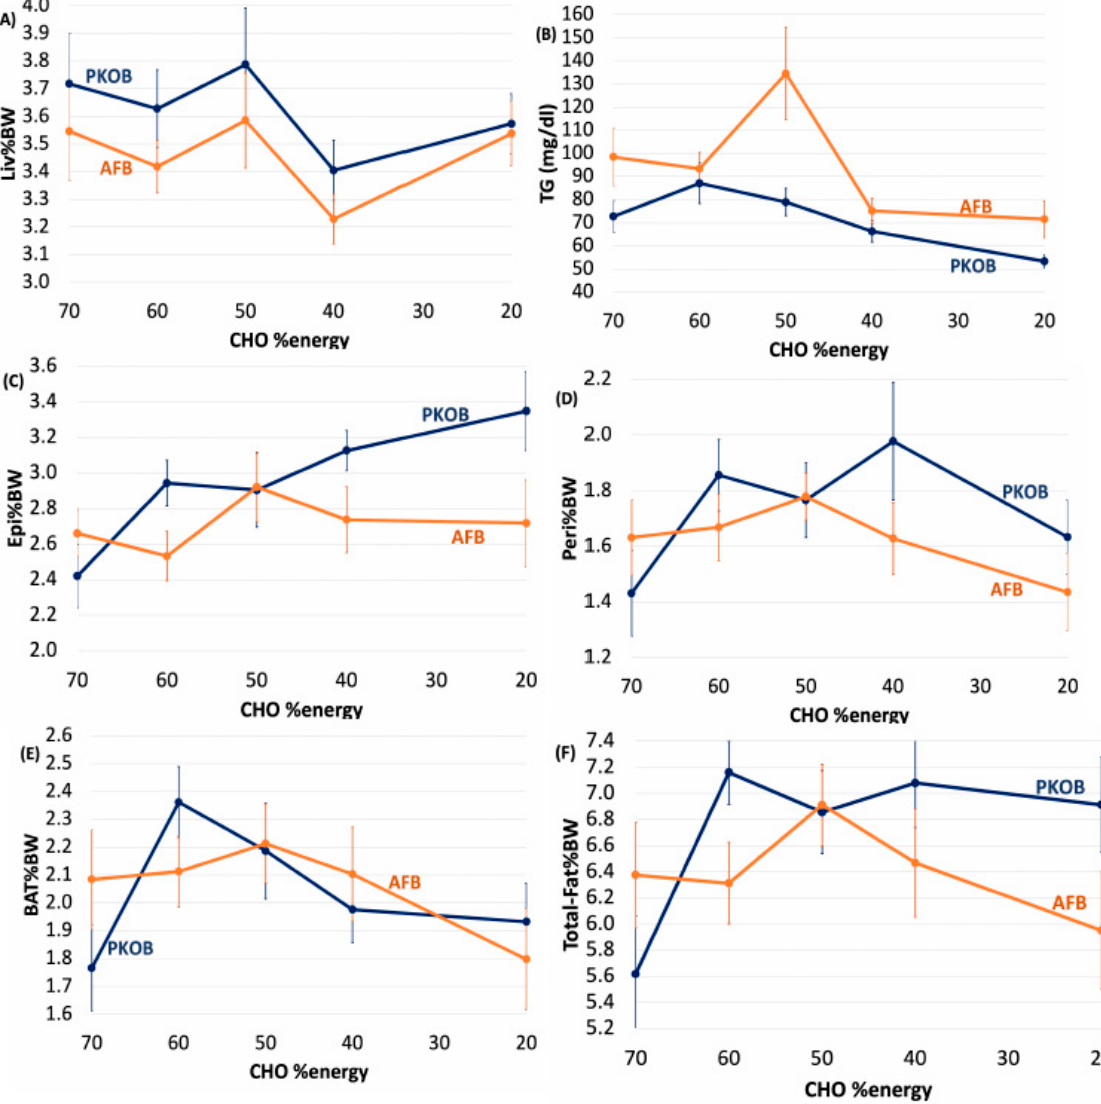
Figure 2. Necropsy findings for organ weights and plasma TG associated with the CHO:fat ratio across the five diet groups for both PKOB (blue) and AFB (orange). The data follow a pattern similar to that observed in the clinical data in Figure 1. ( A ) PKOB increased liver %BW, and the increase was greater with hiCHO. ( B ) TG was actually greater for AFB than for PKOB, and it peaked with 50% energy as CHO. This trend and peak mirrored that of RBG (Figure 1B) and %susceptible rats (Figure 1G). ( C ) Epididymal fat as %BW (Epi%BW) increased along with fat intake (with CHO intake decreasing) in rats fed PKOB. This trend is converse to the trends we see with TG and RBG, which increases when CHO is high. ( D ) PKOB increased the perirenal fat pad as %BW (Peri%BW)